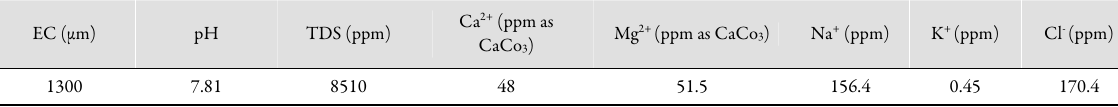
Table 3. Some qualitative properties of the irrigation water EC (µm) pH TDS (ppm)